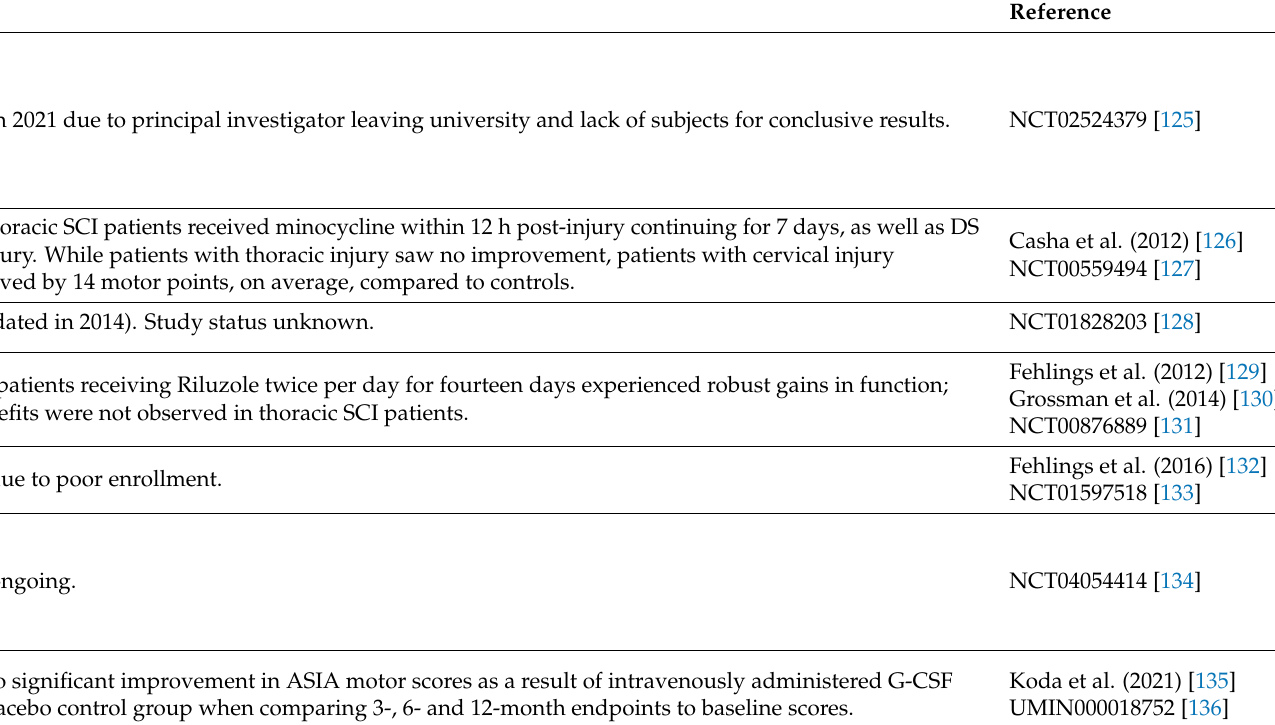
Table 2. Clinical Studies of Pharmacological